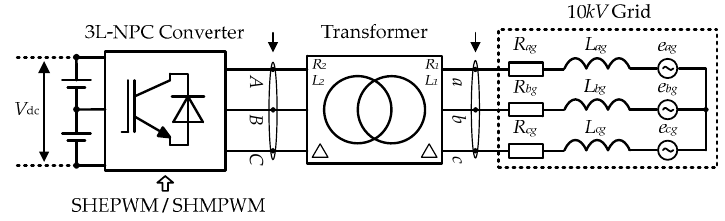
Figure 6. Simulation model based on the proposed HPWM algorithm. Table 3. Parameters used in the simulation